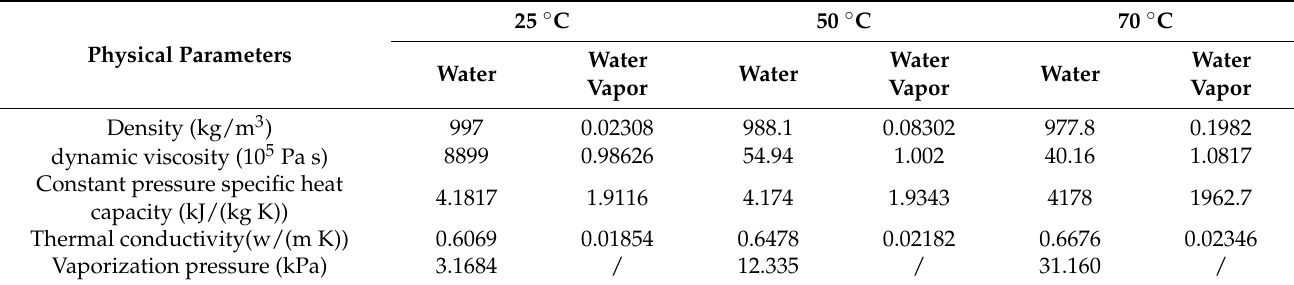
Table 3. Physical parameters of water and water vapor at different